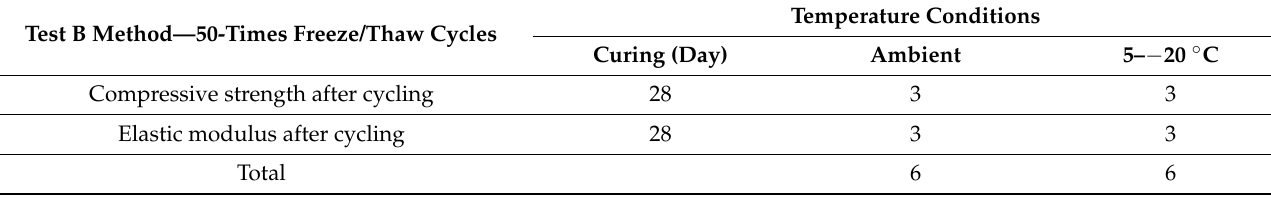
Table 10. Test method and concrete specimens after 50 freeze-thaw